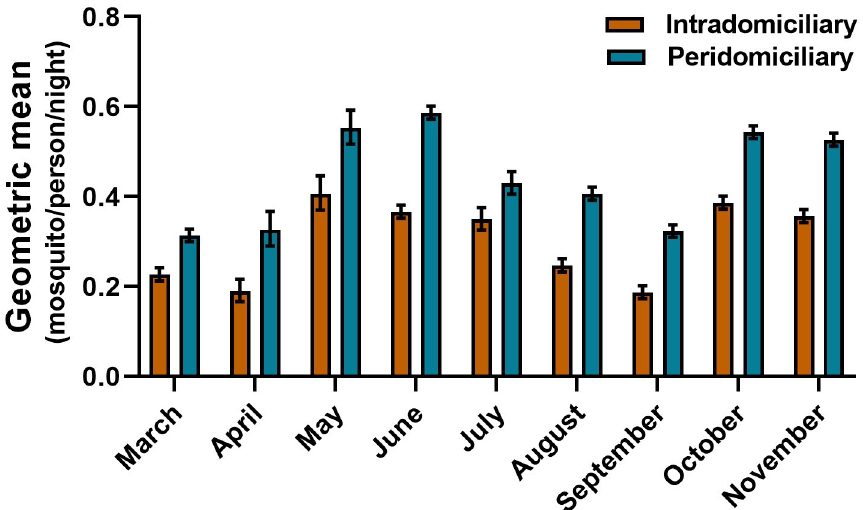
Fig 5. Behavior of the monthly density of Anopheles (Nys . ) darlingi in five communities of the Darien region, between March and November 2016 (geometric mean ± 95% confidence interval). https://doi.org/10.1371/journal.pone.0250059.g005 vivax -positive An . (Nys . ) darlingi samples, seven positive pools were from the community of Bajo Chiquito (4.0%), two pools from Marraganti (1.1%) and two pools from Alto Playona (1.1%) (Fig 1). All other species were negative for P . vivax by the ssrRNA PCR technique. All collected samples tested negative for P . falciparum . Most positive samples were captured in the peridomicile, and only two samples from An . (Nys . ) albimanus were collected in the extra- domicile using LTs in the community of Alto Playona. From the positive pool samples, it was possible to genotype P . vivax in seven of them, four from An . (Nys . ) darlingi and three from An . (Nys . ) albimanus by sequencing the csp gene marker. Amplified products were in the range between 700 to 800 bp and their sequence analy- sis determined that they were homologous to the VK210 variant, grouping together with other isolates from Central America (Fig 6). Sequences from this study are available at the GenBank